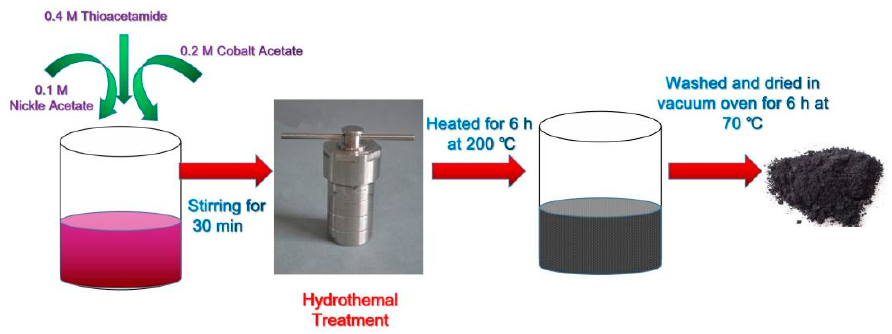
Figure 1. The synthesis process of NiCo 2 S 4 by the hydrothermal method.